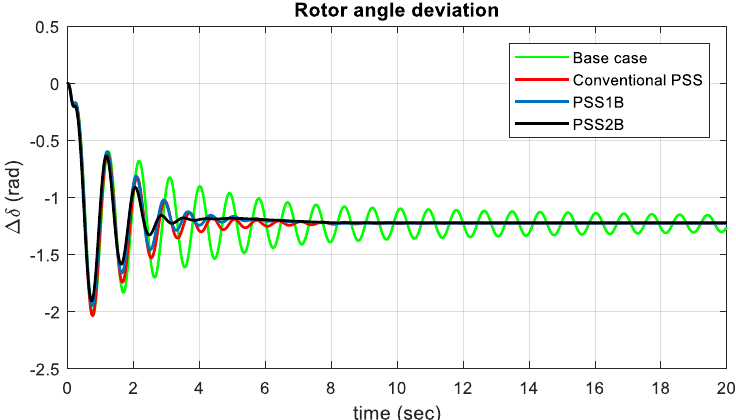
Figure 22. Rotor angle deviation of the power system at light loading.